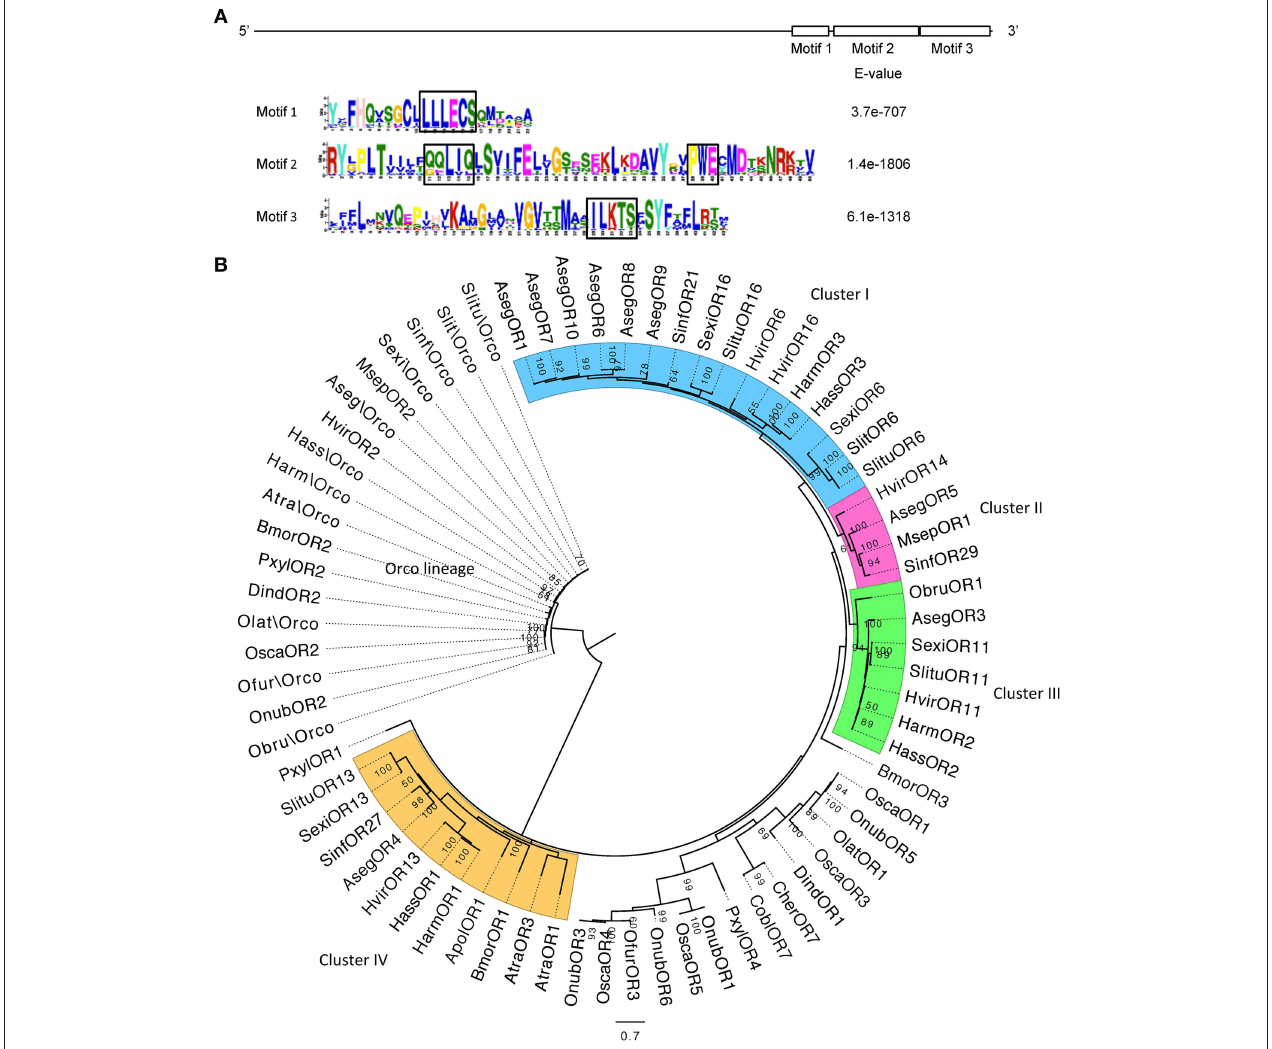
FIGURE 1 | The motif sequences and phylogeny of moth pheromone receptor genes. (A) The upper bar indicates the location of the three motifs on the PR sequences. The lower shows the sequences of the three motifs and respective E -values. The signature sequences in the motifs are boxed in black. (B) The evolutionary history was inferred with MEGA6 by using the Maximum Likelihood method based on the LG model ( Le and Gascuel, 2008; Tamura et al., 2013). The tree with the highest log likelihood ( − 22599.7) is shown. Support values above 50% are labeled next to the branches, which were derived from 100 bootstrap replicates. Initial tree for the heuristic search were obtained by applying the Neighbor-Joining method to a matrix of pairwise distances estimated using a JTT model. A discrete Gamma distribution was used to model evolutionary rate differences among sites [5 categories ( + G, parameter = 2.6982)]. The tree was rooted with the Orco lineage. Color coding indicates the four different orthologous